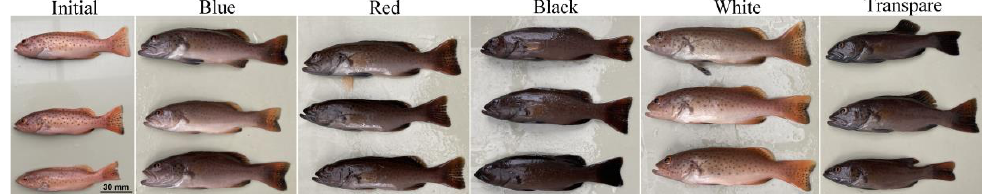
Figure 1. The apparent skin color of P. leopardus rearing in different background tanks.